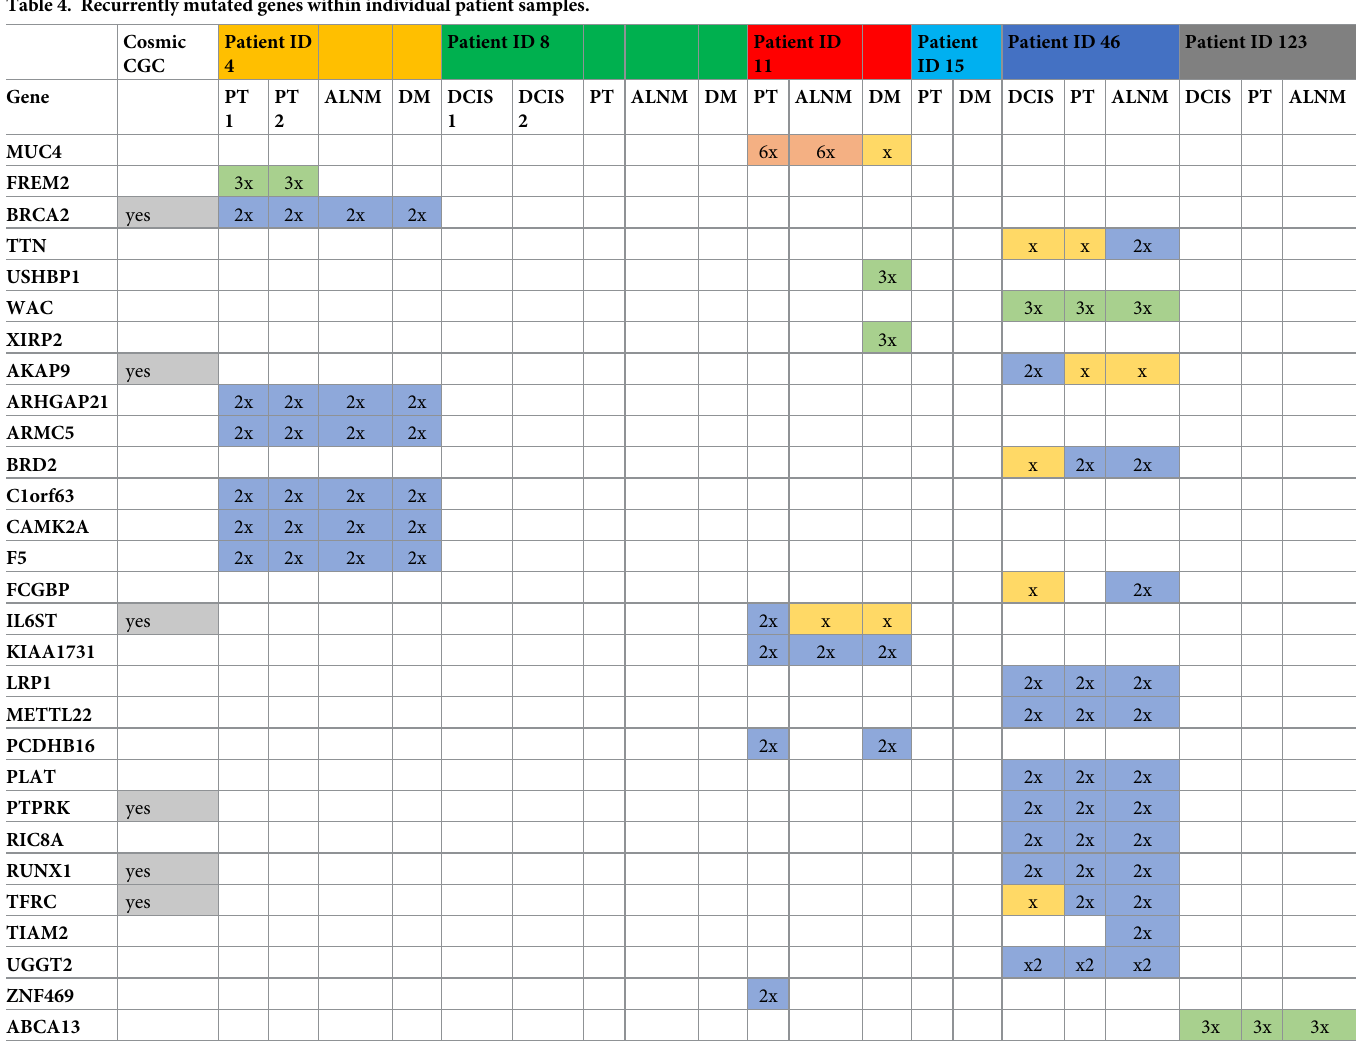
Only non-synonymous and splice site mutations are included. Cosmic CGC: Included in the Cosmic Cancer Gene Census. x: one mutation. 2x: two mutations. 3x: three mutations. 6x: six mutations. DCIS: ductal carcinoma in situ. DM: asynchronous distant metastasis. PT: patient. ALNM: axillary lymph node